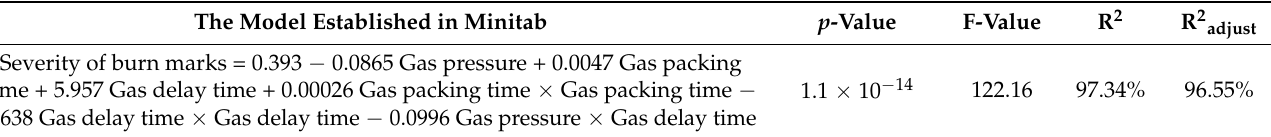
Table 4. Regression model between gas parameters and burn marks. The Model Established in Minitab